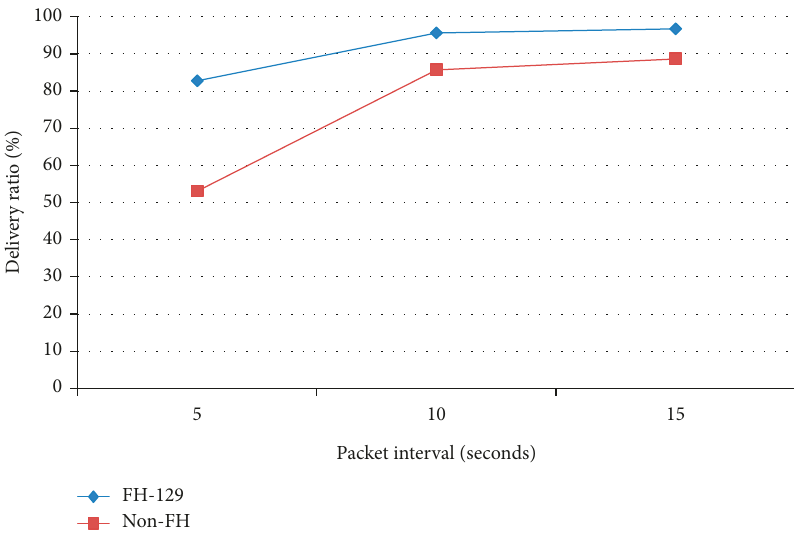
Figure 13: Average delivery ratio (FH-129 vs. non-FH